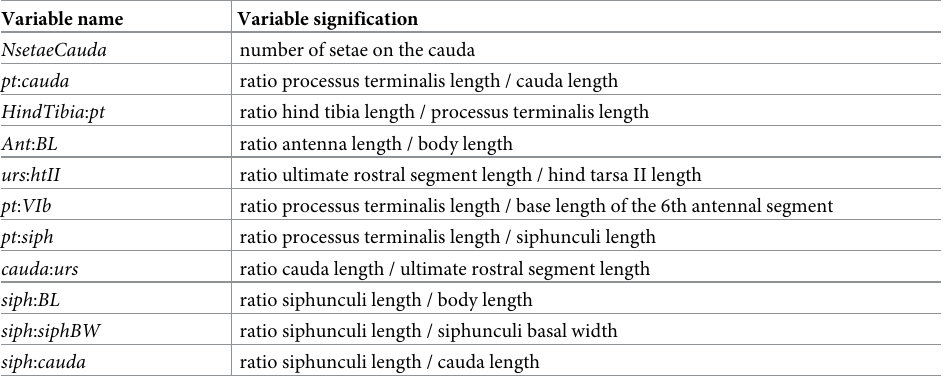
Table 1. List of the 11 morphological variables used in the discriminant analysis of principal components (DAPC) analysis. Variable